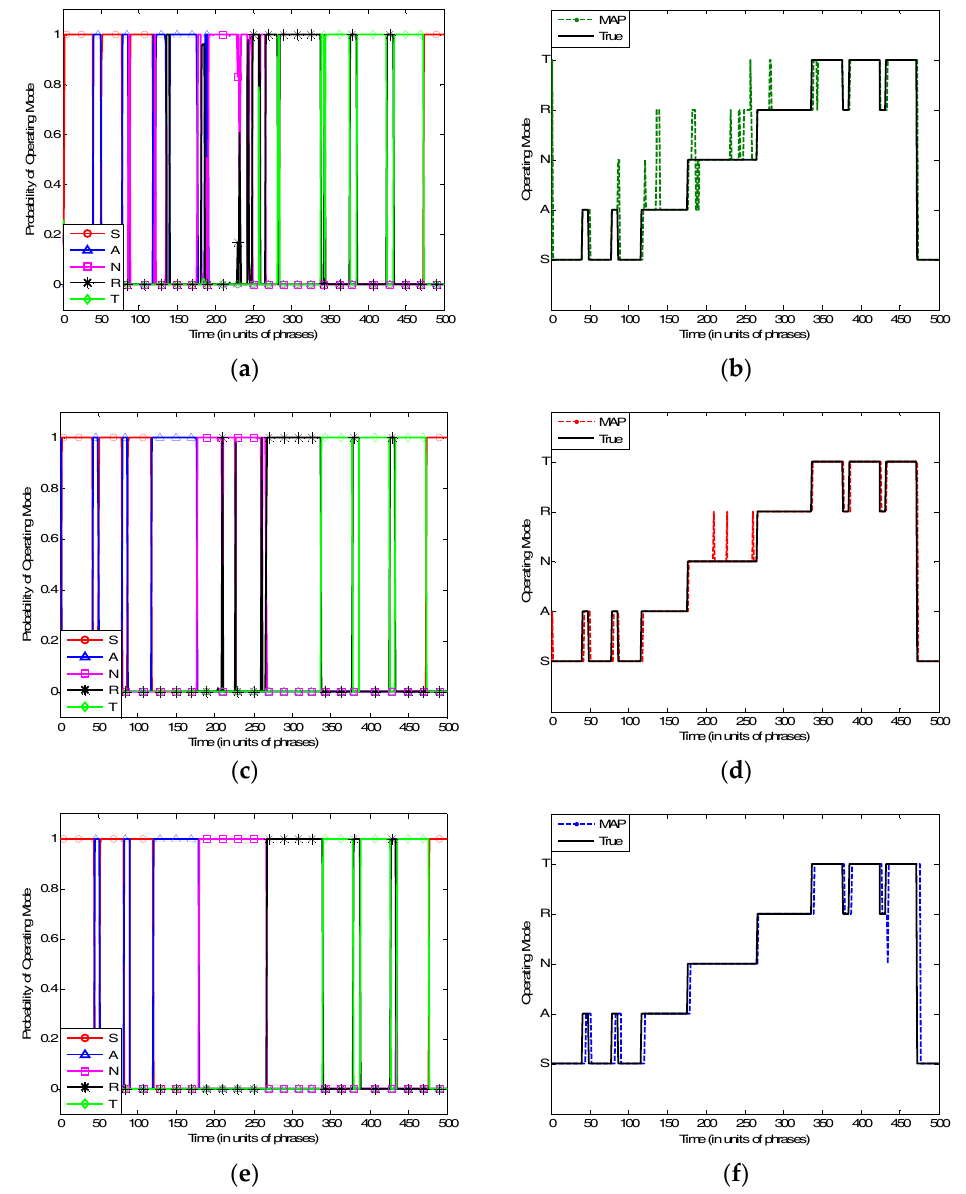
Figure 4. Recognition for MFR operating modes based on three recognition algorithms. ( a ) Probability distribution estimation based on HMM; ( b ) recognition based on HMM; ( c ) probability distribution estimation based on PSR and grid-filter; ( d ) recognition based on PSR and grid-filter; ( e ) probability distribution estimation based on PSR and proposed method; and ( f ) recognition based on PSR and proposed method.